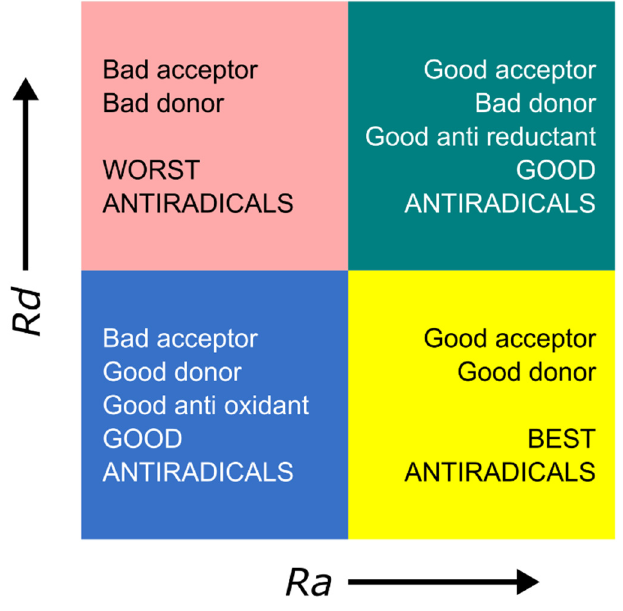
Figure 1. Donor–acceptor map (DAM).